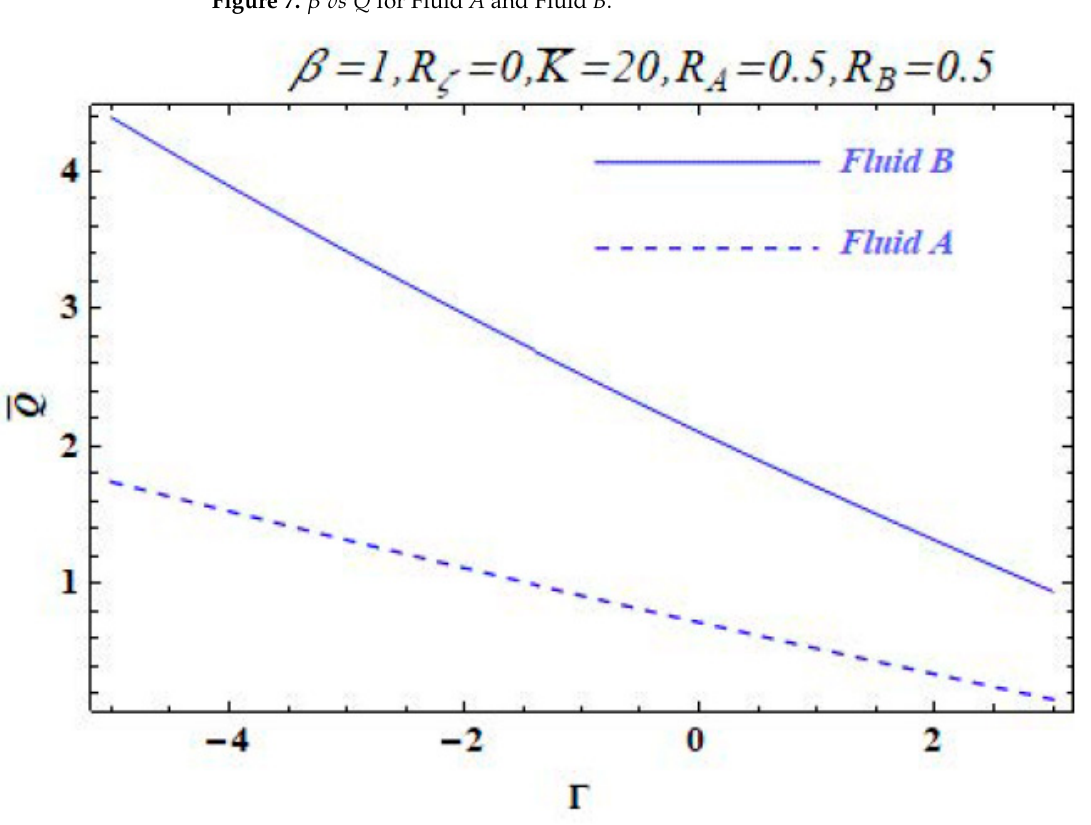
Figure 8. Γ vs Q for Fluid A and Fluid B Figure 8. 𝛤 𝑣𝑠 𝑄(cid:3364) for Fluid A and Fluid B . Figure 8. 𝛤 𝑣𝑠 𝑄(cid:3364) for Fluid A and Fluid B .